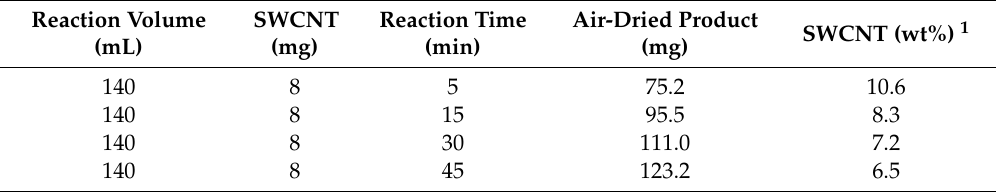
Table 1. Composition of electroless bath, reaction time, and yield of products. SWCNT: single walled carbon